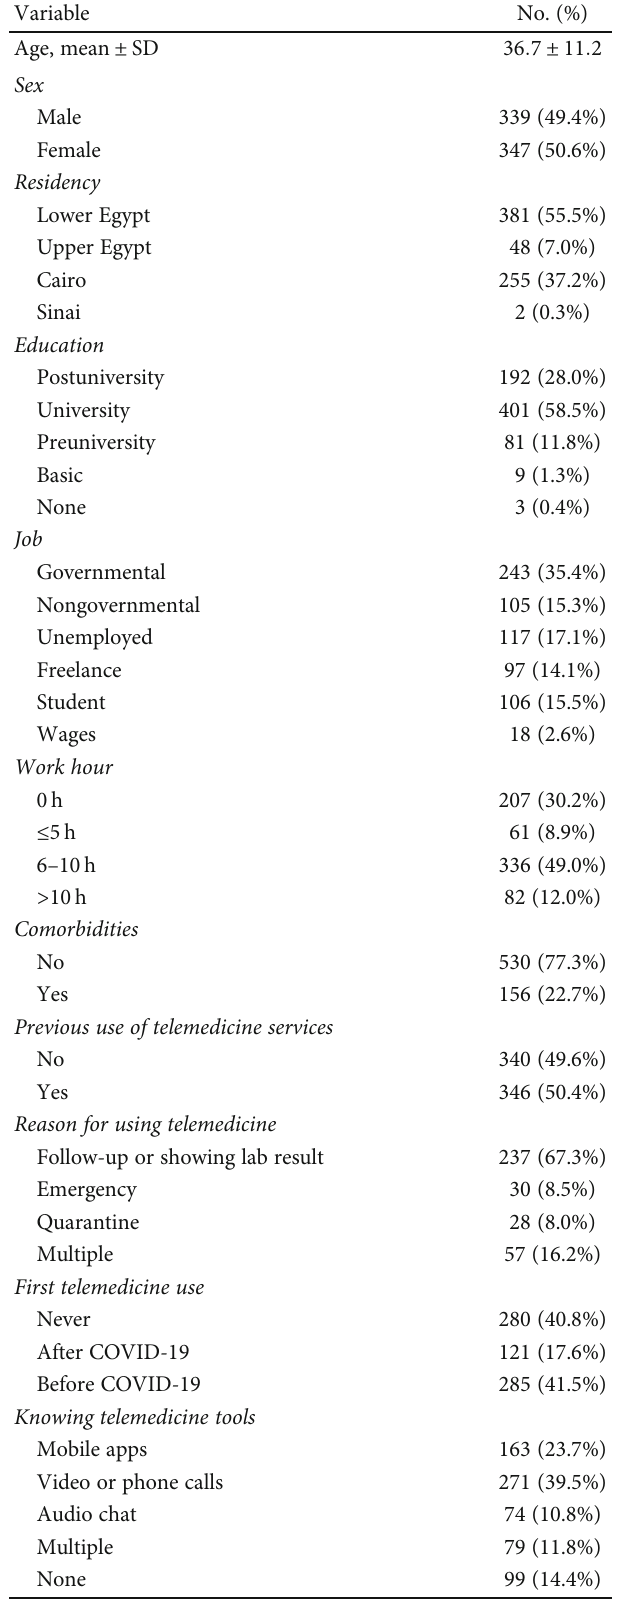
Table 1: Demographic and behavioral characteristics of the participants ( n = 686 ).